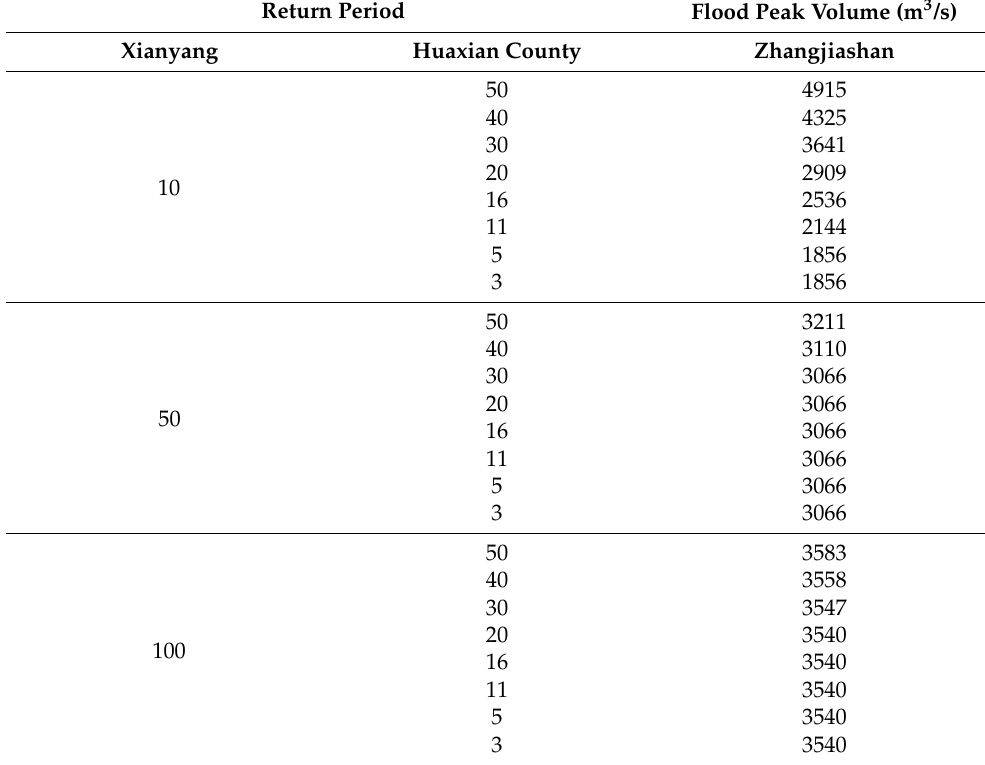
Table 4. Flood peak volume of Zhangjiashan under different return periods of Xianyang and Huax- ian